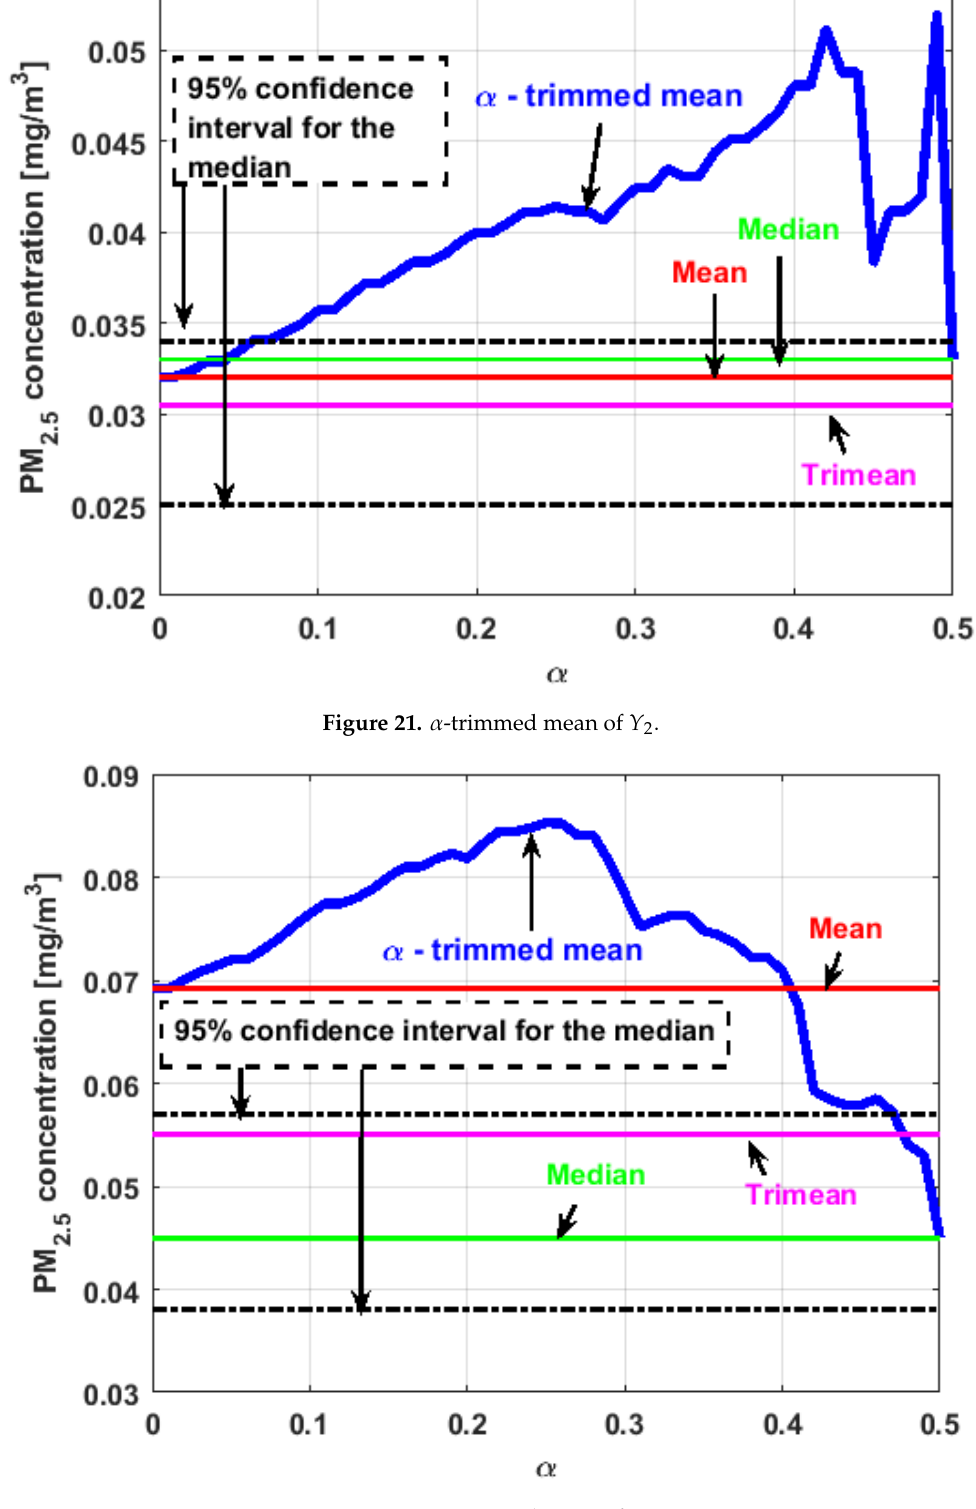
Figure 22. 𝛼 -trimmed mean of 𝑌 3 . Figure 22. α -trimmed mean of Y 3